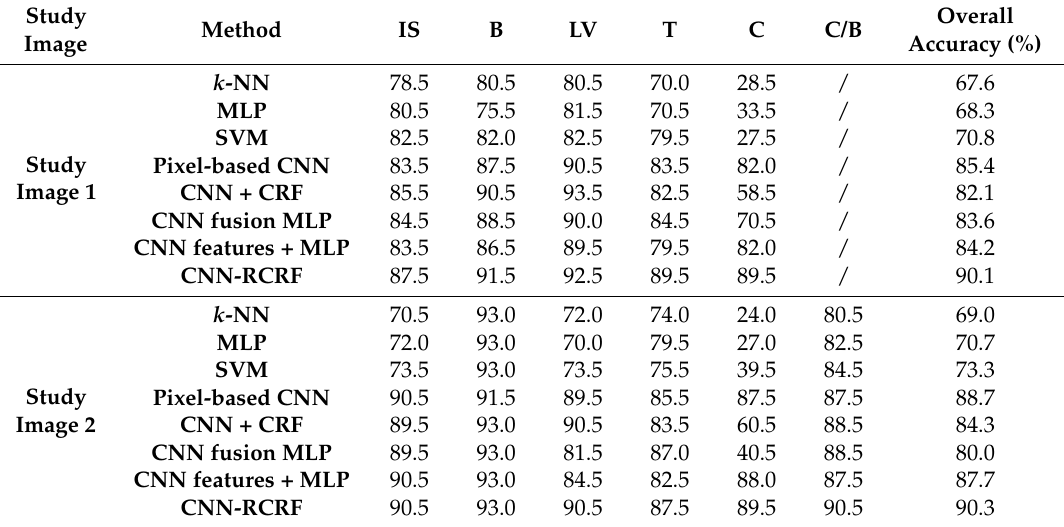
Table 2. Classification accuracy comparison of eight